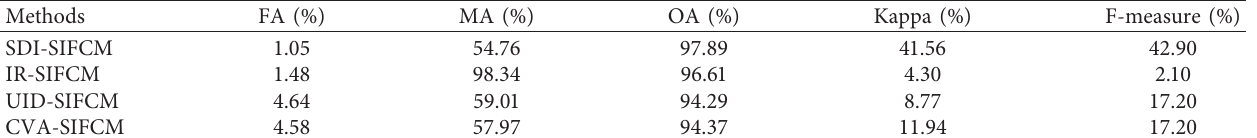
Table 2: Accuracy evaluation of the first comparative experiment of the second group of